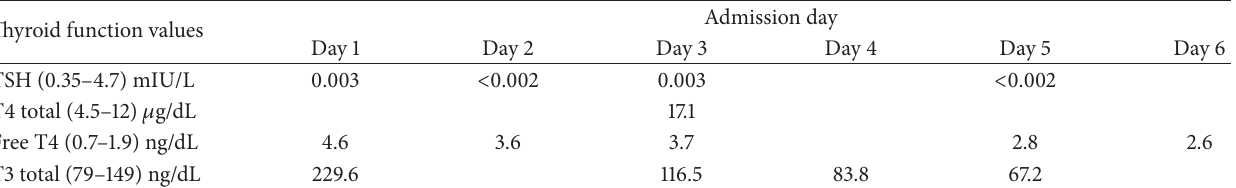
Table 1: Thyroid laboratory results during hospital admission.